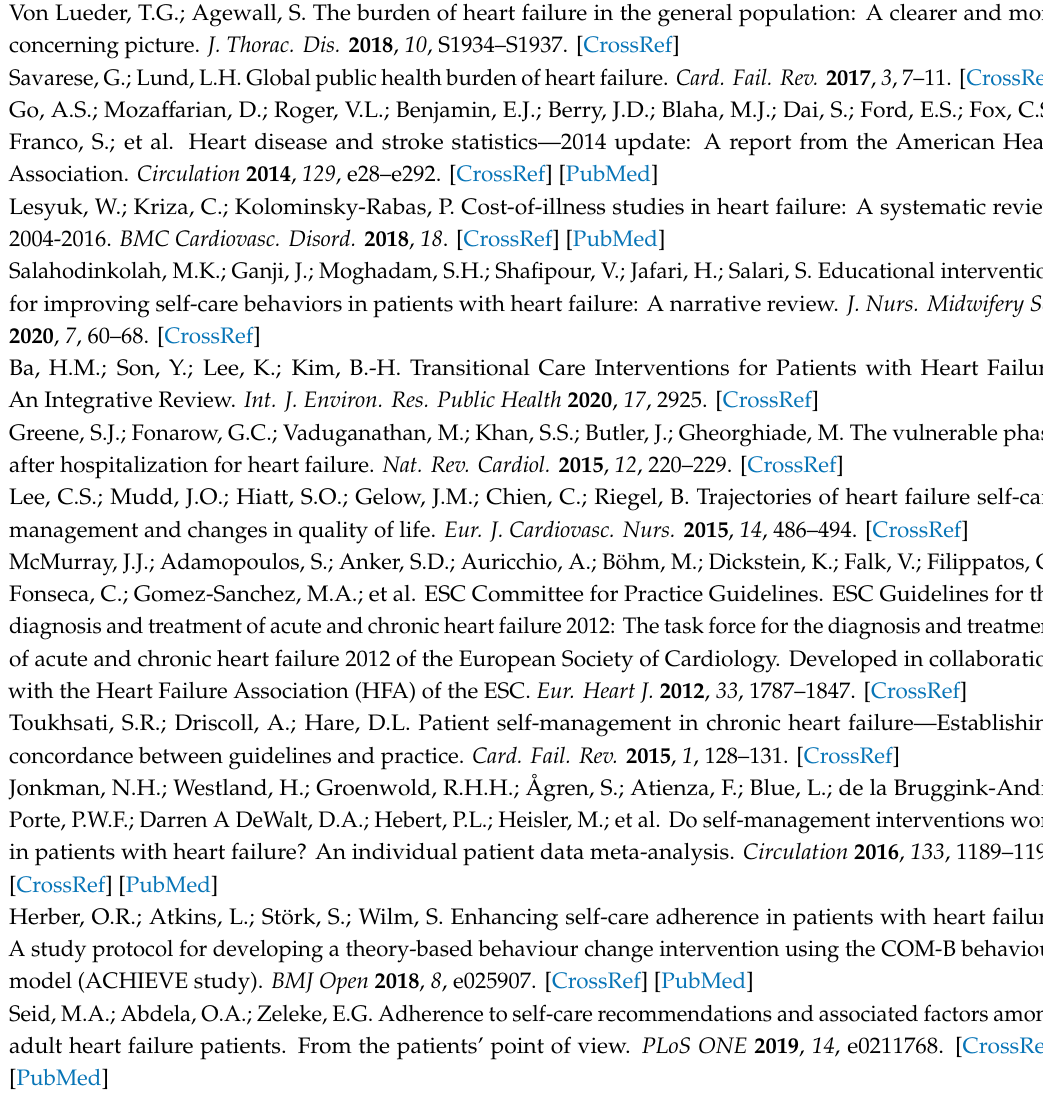
Table S1: Search